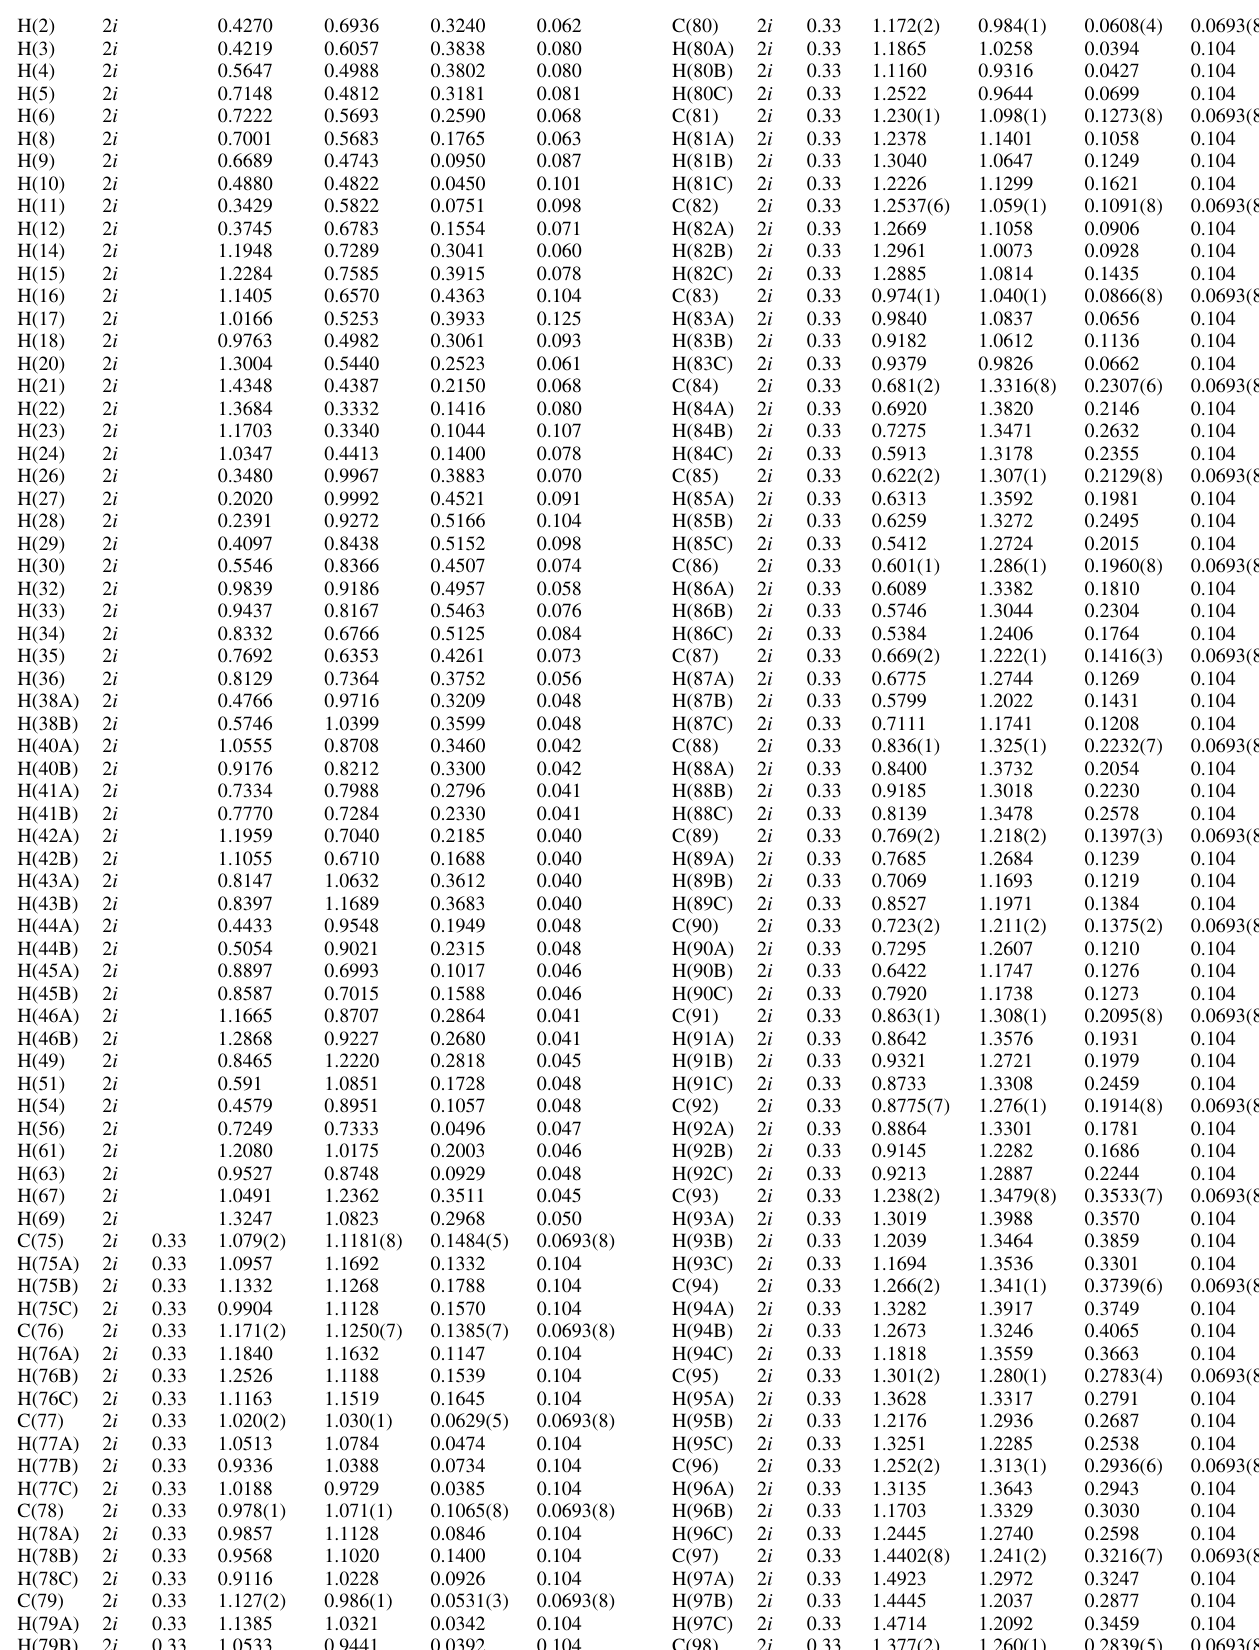
Table 2. Atomic coordinates and displacement parameters (in Å 2 ) . Atom Site